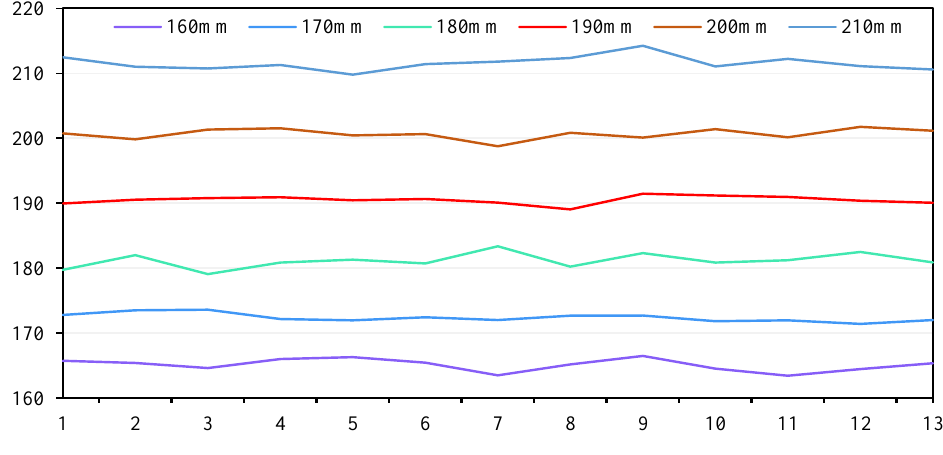
Figure 12. Image processing results of each interval. ( a ) Image processing results of 160 mm; ( b ) Image processing results of 170 mm; ( c ) Image processing results of 180 mm; ( d ) Image processing